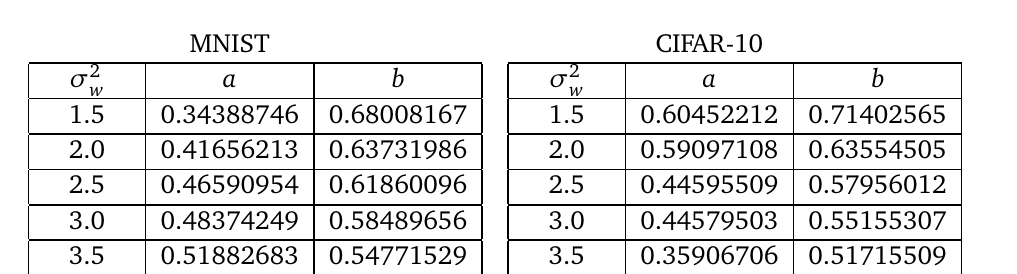
Table 1: Parameter values for the ansatz (90), fitted to the after-training KL data in fig. 8. Note that since b < 1, the second term in (90) vanishes asymptotically, so that a gives the asymptotic value of the KL